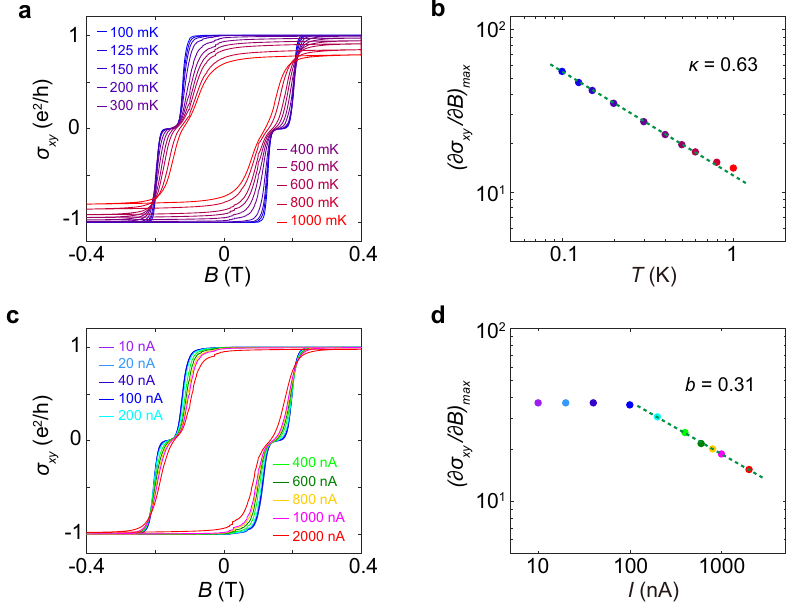
Fig. 2 Scaling behaviors and critical exponents in the quantum critical regime. a Field dependence of σ xy at different temperatures. All curves are measured using a 10 nA excitation current. b Temperature dependence of ( ∂ σ xy / ∂ B ) (cid:4) T (cid:2) κ . c Field dependence of σ xy at different currents. All curves are measured at 200 mK. d Current dependence of ( ∂ σ ( ∂ σ xy / ∂ B ) max